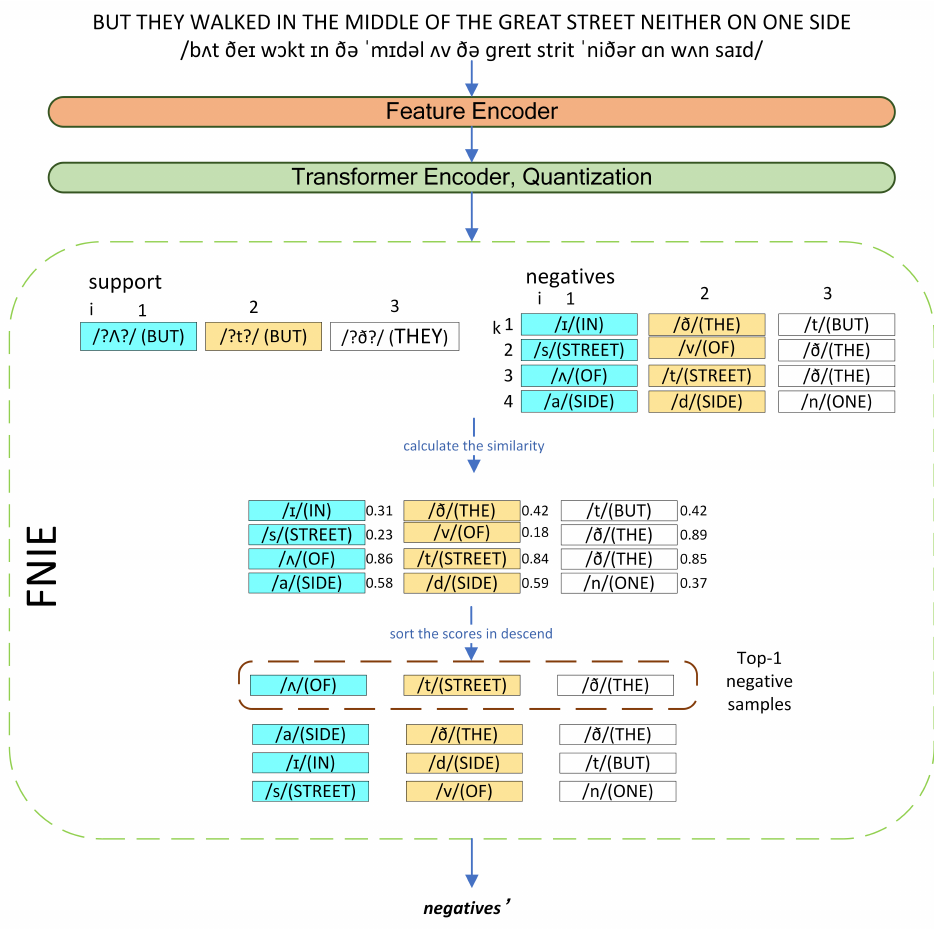
Figure 6. A sample of finding parts for the FNIE. The Transformer Encoder generates support vectors, and quantization generates negatives. The set of negative samples used for the final loss value calculation is generated by